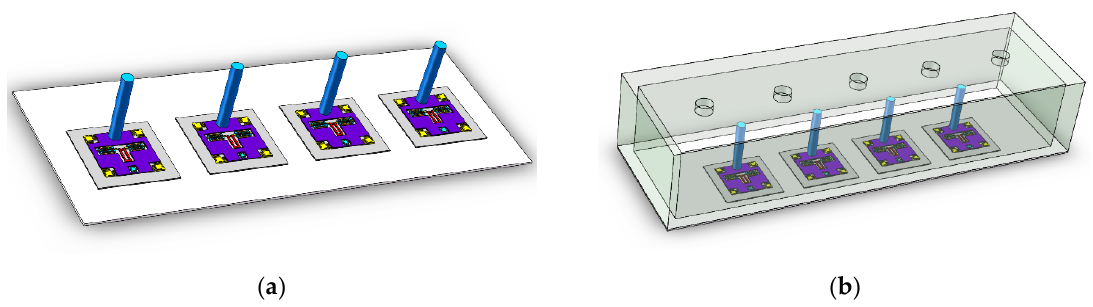
Figure 3. Schematic diagram of artificial lateral line system. ( a ) Superficial neuromast flow velocity